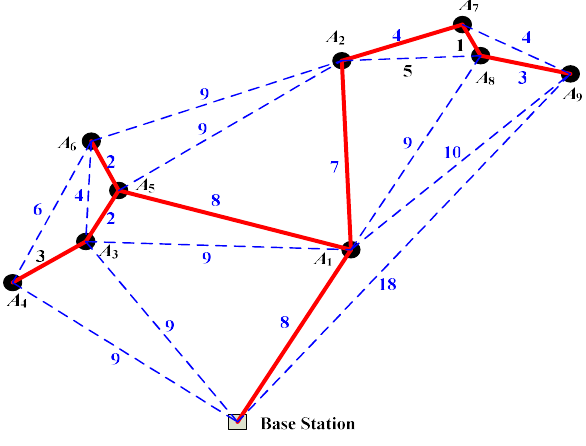
Figure 4. Example of a communication topology and its corresponding minimum weighted spanning tree.